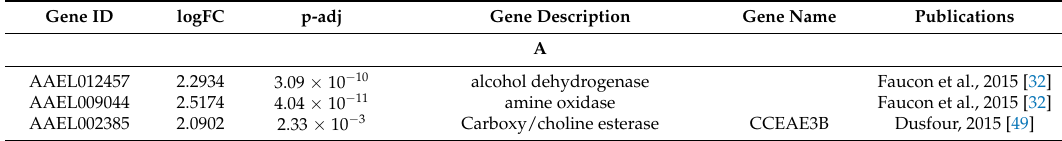
Table 1. Transcription profiles of detoxification enzymes associated with permethrin resistance. (A) Genes related to detoxification significant upregulated in the Zika infection in the permethrin resistant (KW) strain compared with susceptible (OR) strain Aedes aegypti 7-days post infection. (B) Detoxification related gene significant upregulated/downregulated in the Control in the permethrin resistant (KW) strain compared with the susceptible (OR) strain Aedes aegypti 7-days post injection. Gene ID logFC p-adj Gene